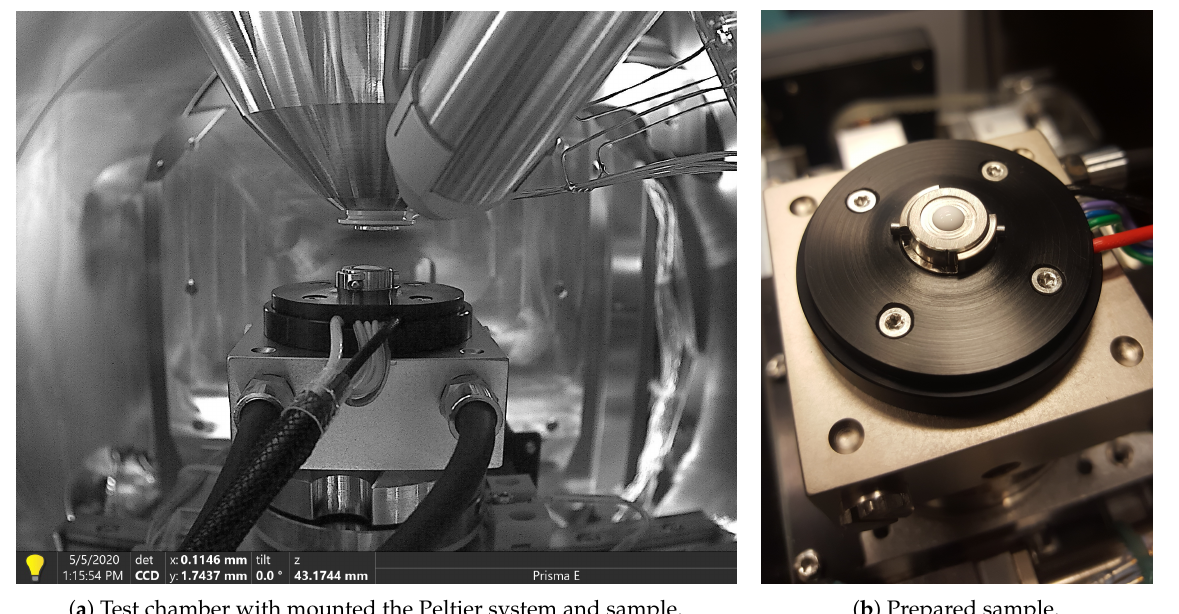
Figure 1. Description of the Scanning Electron Microscope (SEM) chamber and the prepared sample.